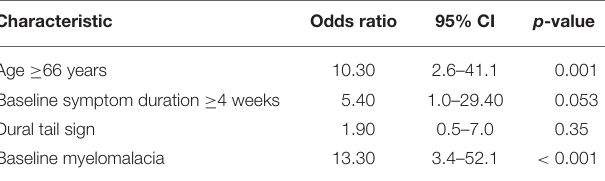
TABLE 4 | Multivariate binary logistic regression analysis of predictors of poor MMS at